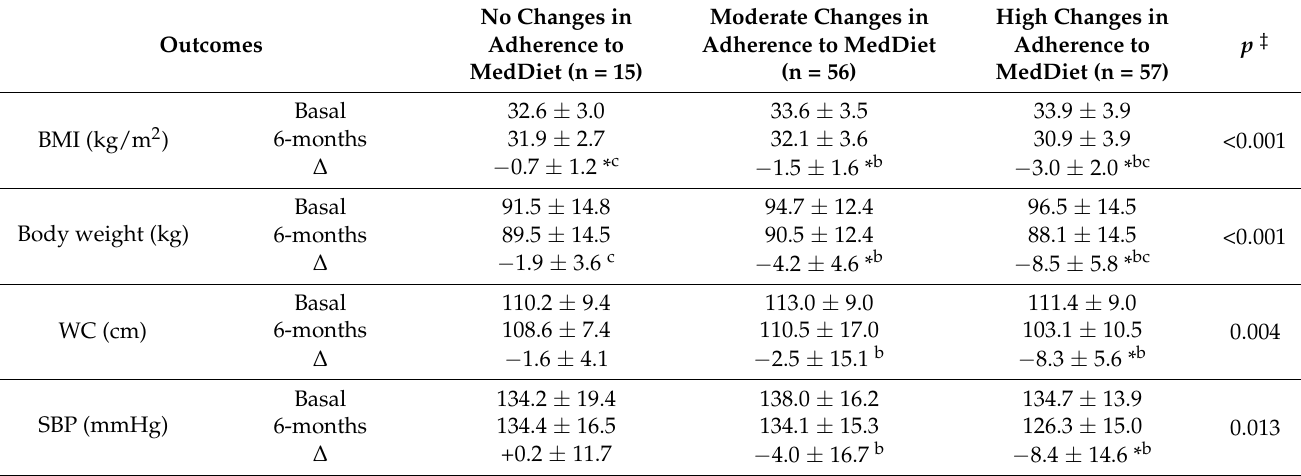
Table 2. Six-month follow-up changes of clinical features according to the changes in adherence to